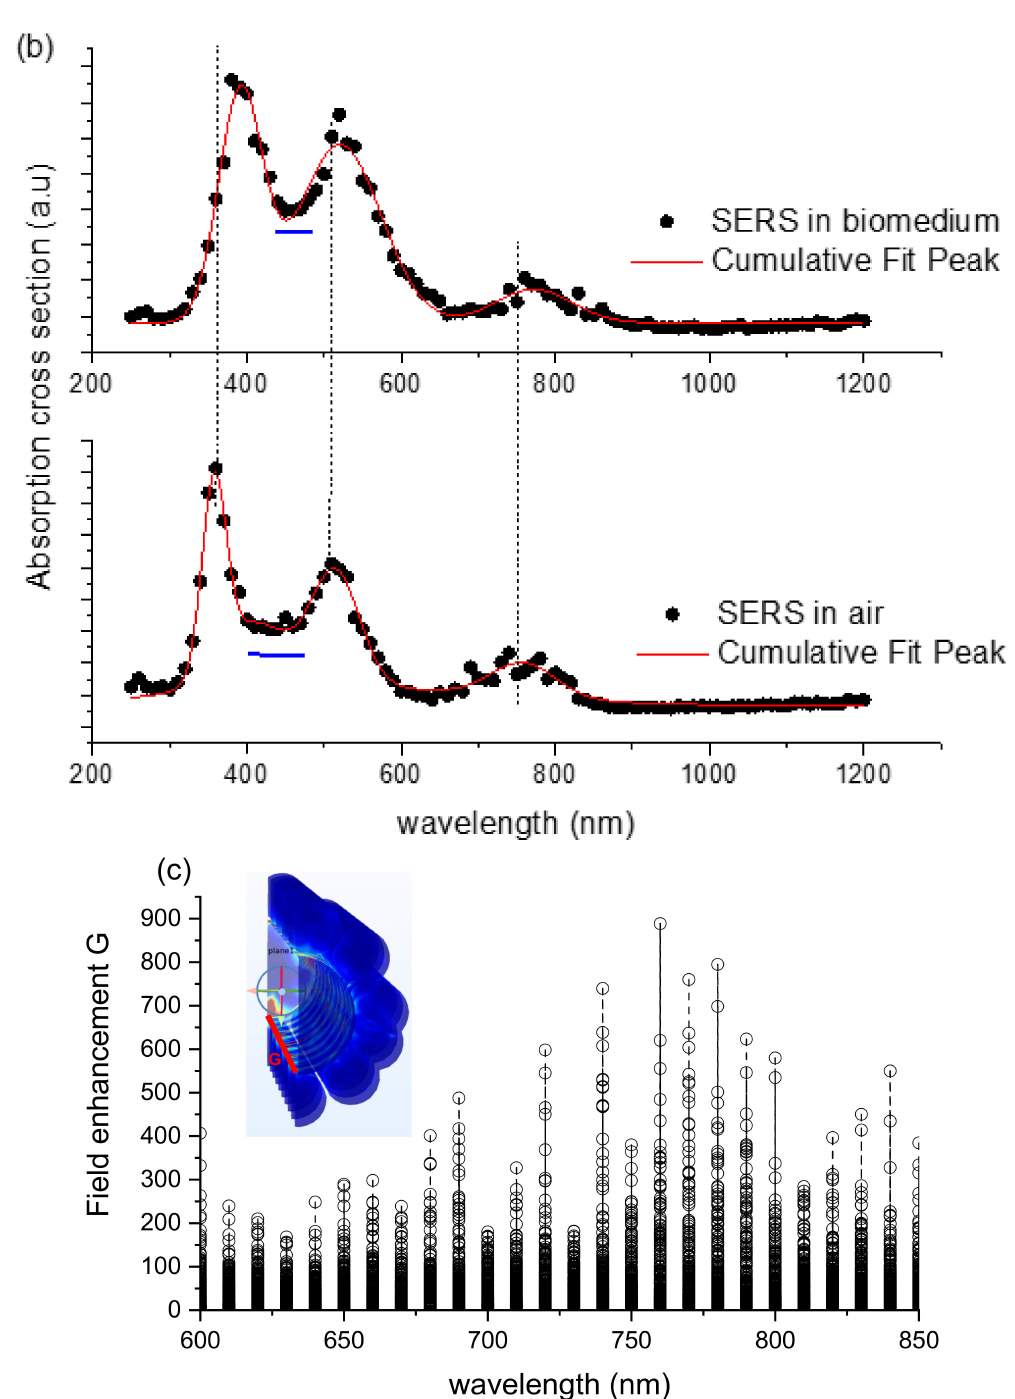
Figure 12. ( a ) 3D simulation of the electromagnetic field enhancement (near-field enhancement) in the silicon wire surrounded by a spherical silver and gold nanoparticle. The model is initially placed in the air domain. Silicon wire radius = 12 nm, length = 300 nm, Ag and Au nanosphere radius = 7 nm, the number of Ag and Au nanosphere covering the silicon wire is 108 ( b ) Absorption cross-section of the 3D silicon nanowire surrounded by silver and gold nanosphere proteins. ( c ) Enhancement factor G: E loc /E 0 of the silicon wire edge (represented with red color in the inset) in the bio-medium. The maximum enhancement factor obtained is